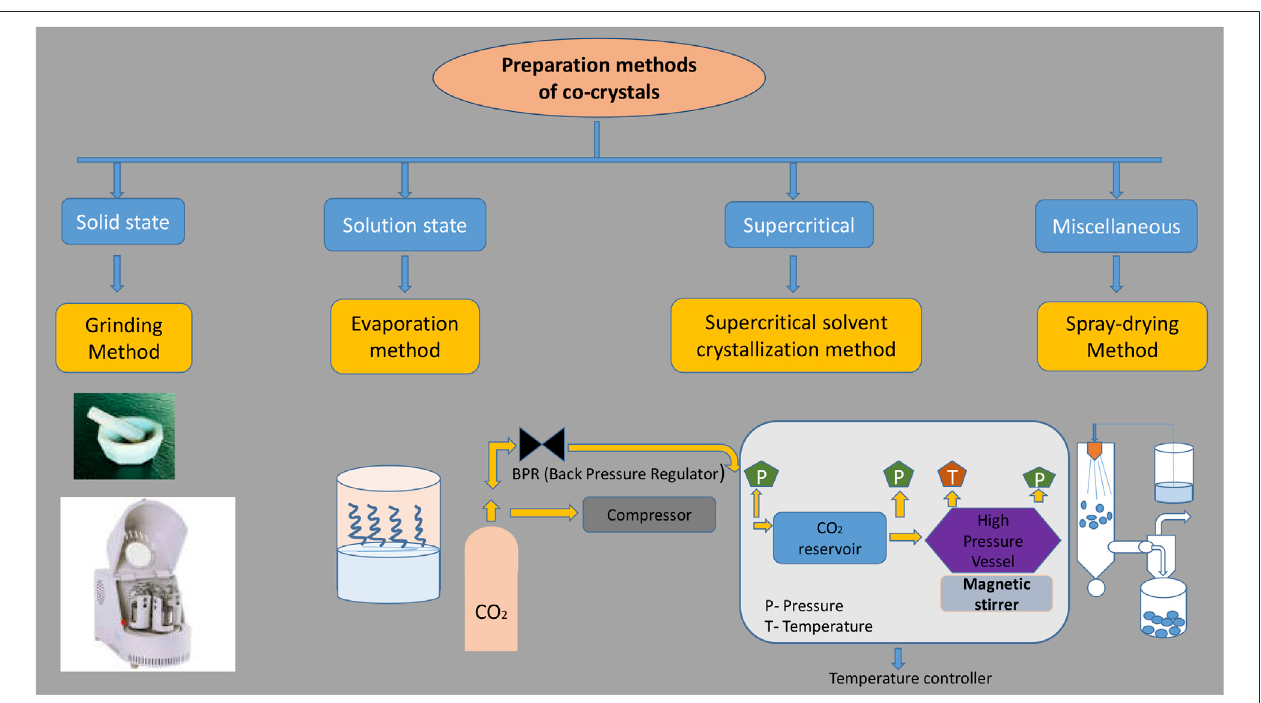
FIGURE 1 | Different types of cocrystallization